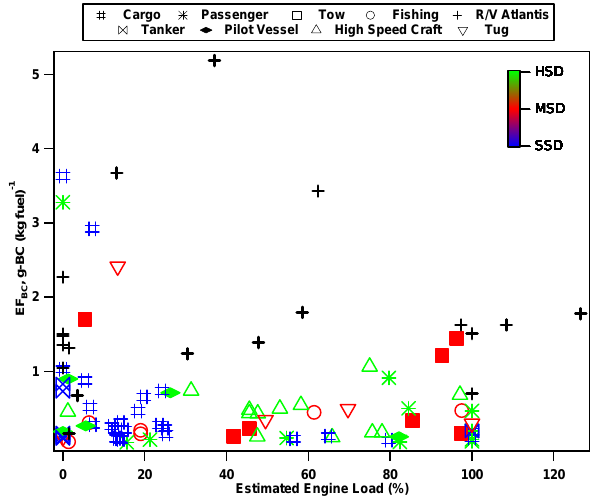
Fig. 6. Individual vessel EF BC values as a function of estimated engine load. The markers correspond to ship type and the colours correspond to engine type for individual